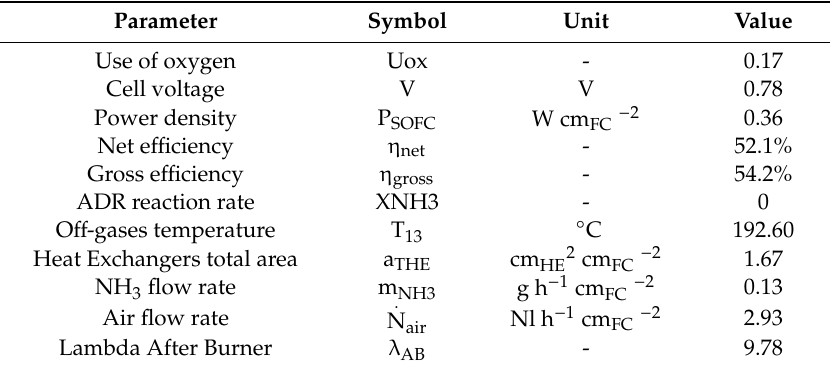
Table 10. Outputs parameters values of system nominal conditions.